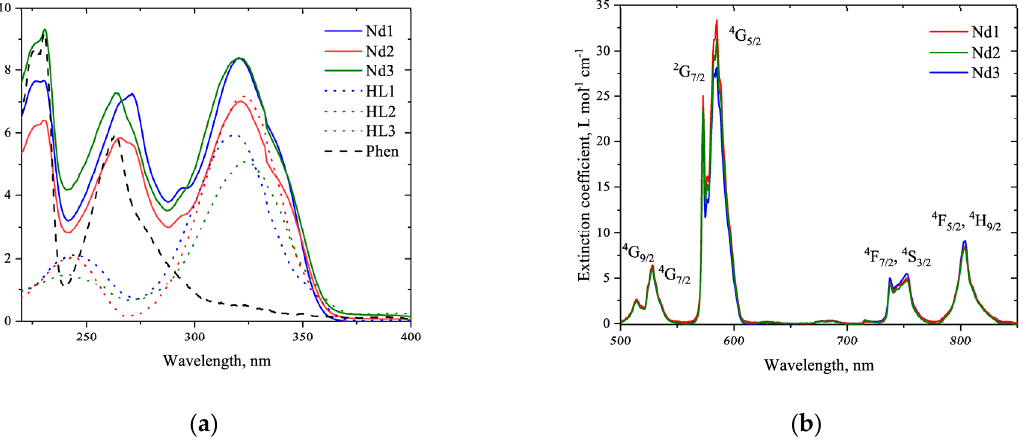
Figure 3. Photoluminescence spectra (365~nm excitation wavelength) ( a ) and excitation spectra (recorded at 1060~nm) ( b ) for complexes Nd1 - Nd3 in DMSO solutions with a concentration of 3·10 − 3 M.